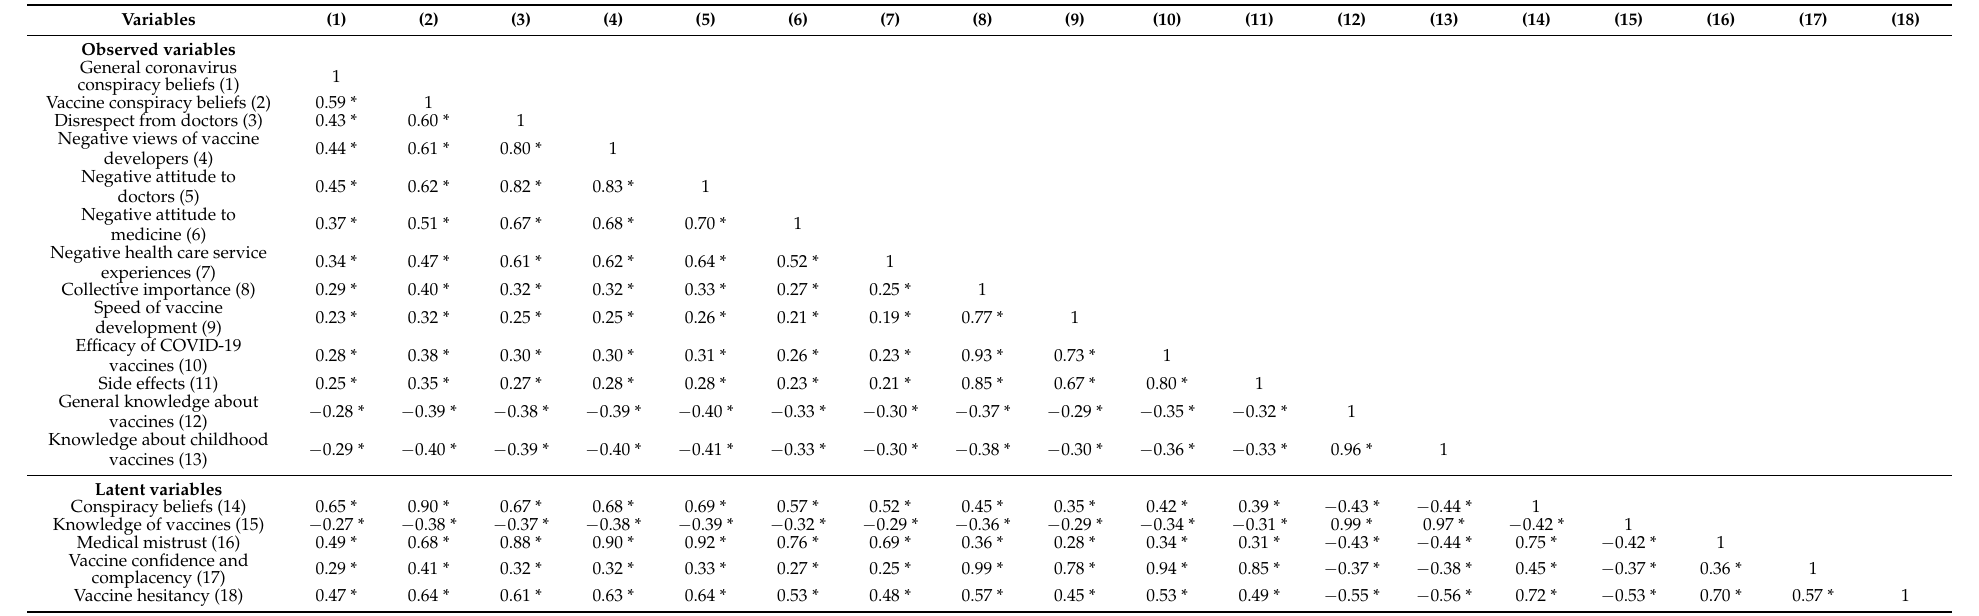
Table 2. Correlation matrix of the variables ( N =